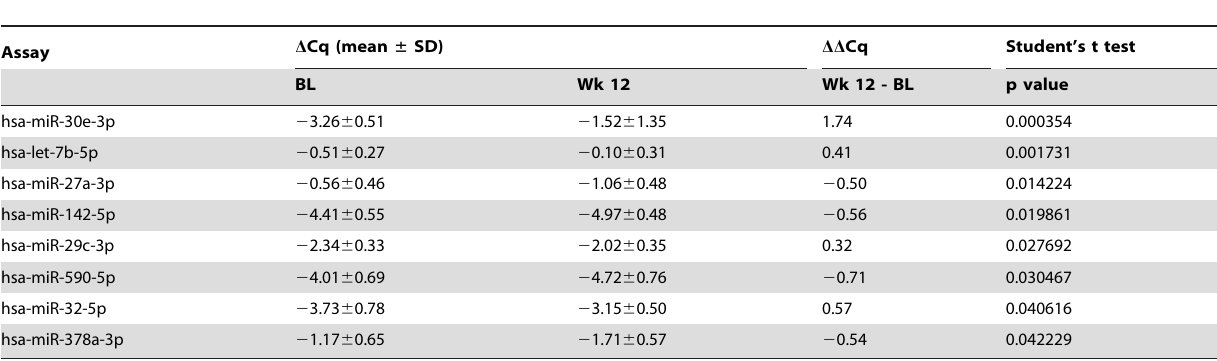
Table 4. Differentially expressed miRNAs comparing Baseline (BL) and Week 12 (Wk 12) sera in 14 Peg-IFN HBeAg negative CHB